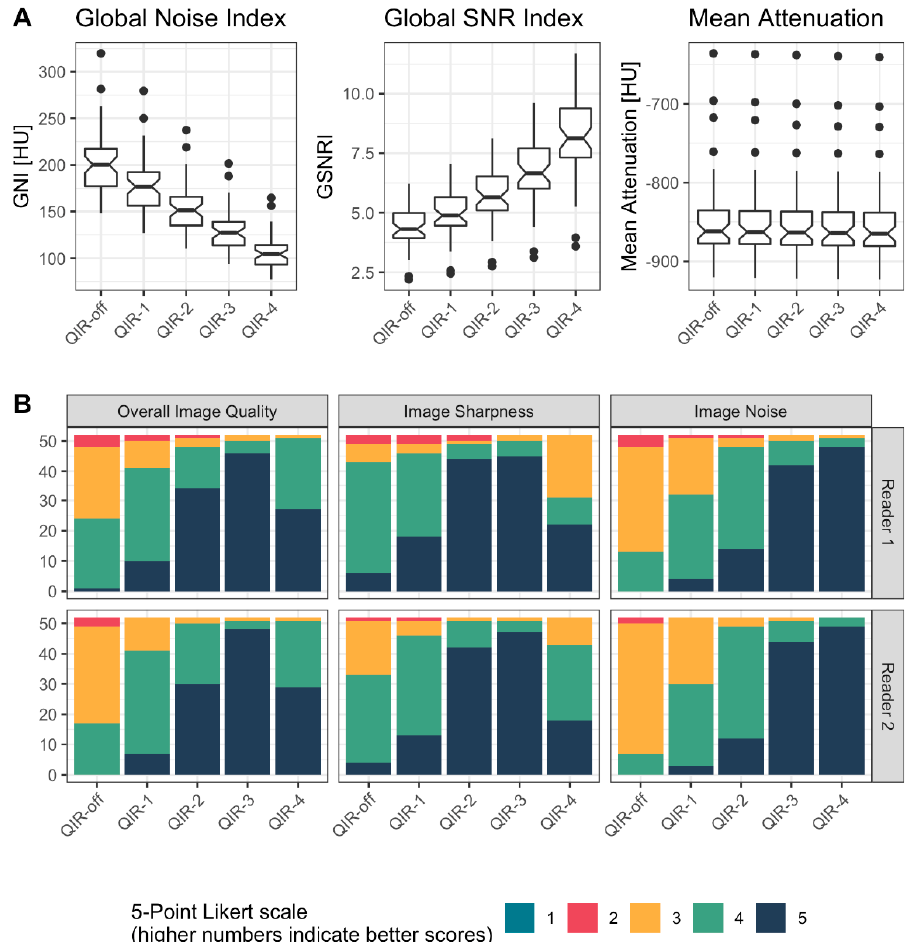
Figure 4. Detailed overview of the results from qualitative and quantitative analysis in patients. ( A ) shows the results from quantitative analysis by means of notched boxplots. A linear decrease of GNI and a linear increase of GSNRI were observed with increasing level of QIR. The CT attenuation was similar among reconstructions. ( B ) shows the results from qualitative analysis by means of stacked bar plots. While QIR-4 achieved highest ratings for image noise, QIR-3 performed best for sharpness and overall image quality. Table 3. Detailed overview of the results from quantitative and qualitative analysis in patients.